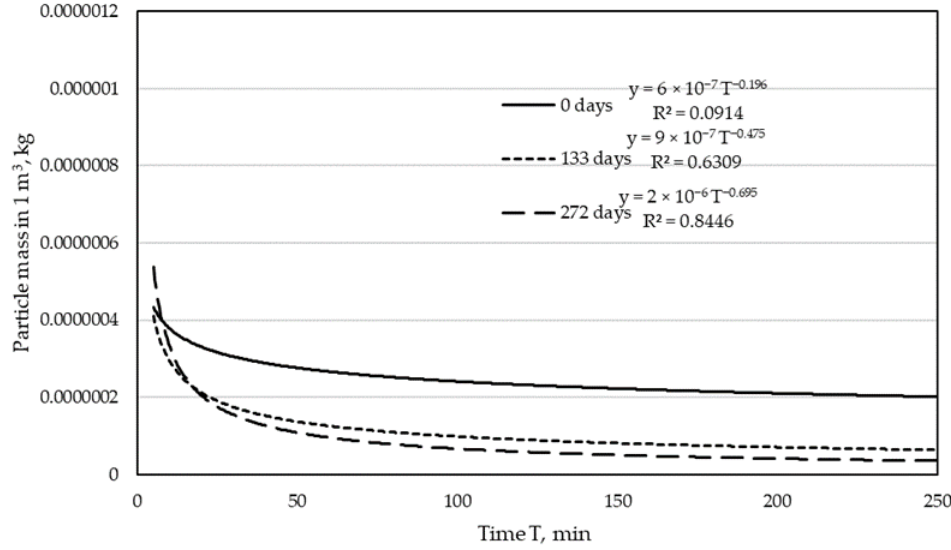
Figure 4. Particle mass in purified air for narrow surfaces treatment line.